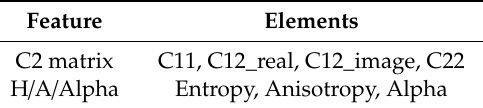
Table 3. Sentinel-1 features.